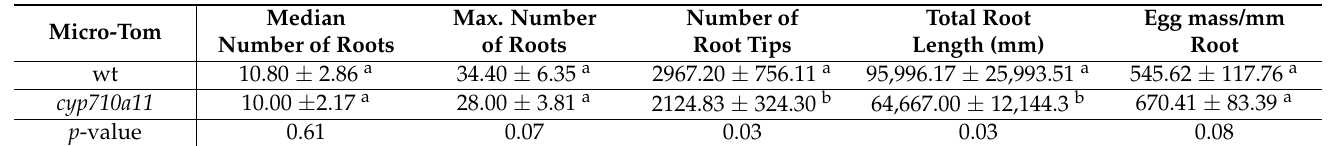
Table 4. Root measurements of the wt and cyp710a11 mutant of cv. Micro-Tom tomato plants infected with M. incognita using RhizoVision Explorer v2.0.3 [19].